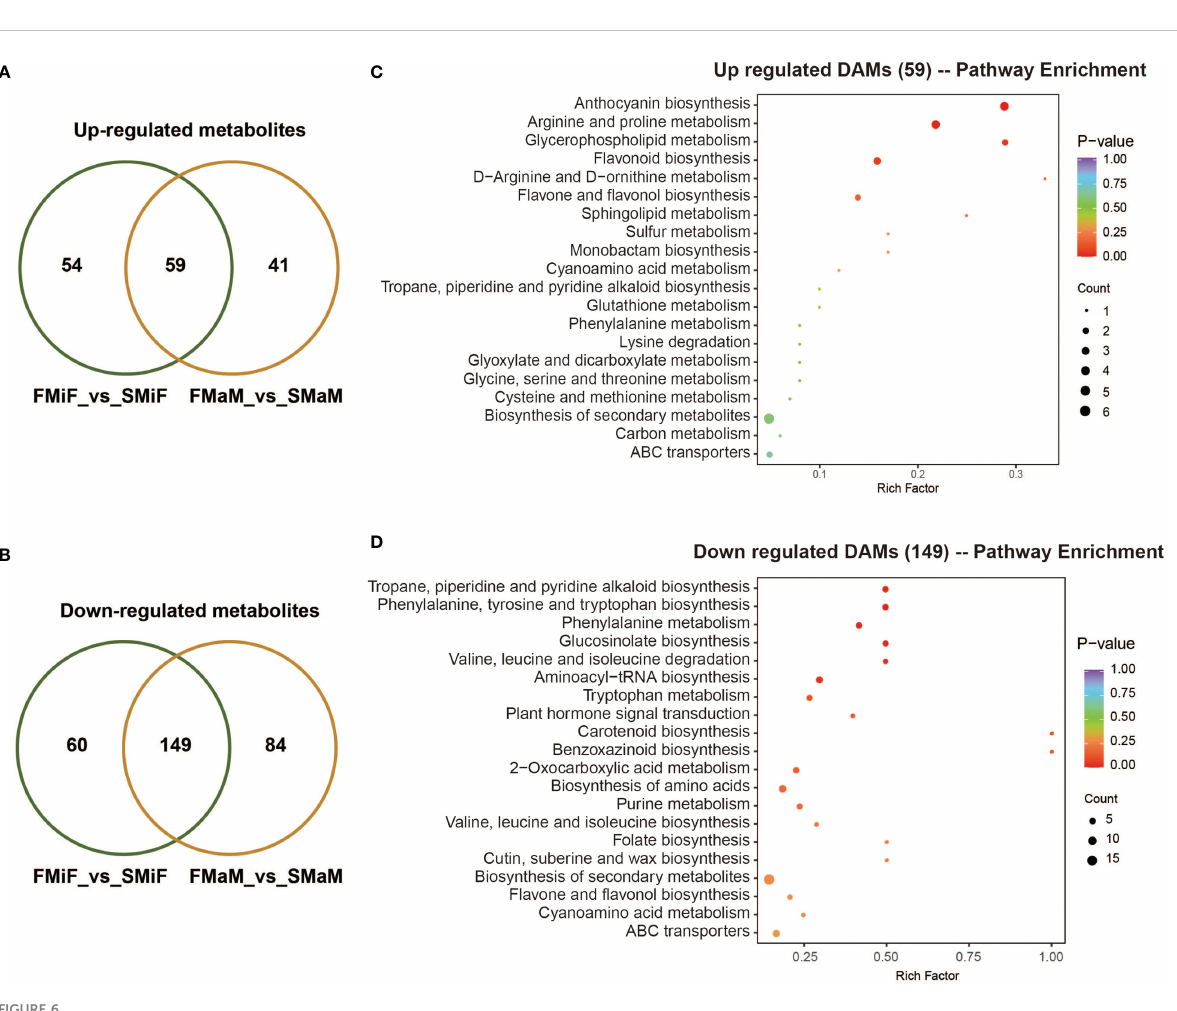
FIGURE 6 Analysis of co-upregulated and downregulated metabolites in fi rst and secondary fl owers. (A) A total of 59 metabolites were co-upregulated. (B) A total of 149 metabolites were co-upregulated. (C) KEGG enrichment analysis of 56 co-upregulated metabolites. (D) KEGG enrichment analysis of 149 co-downregulated